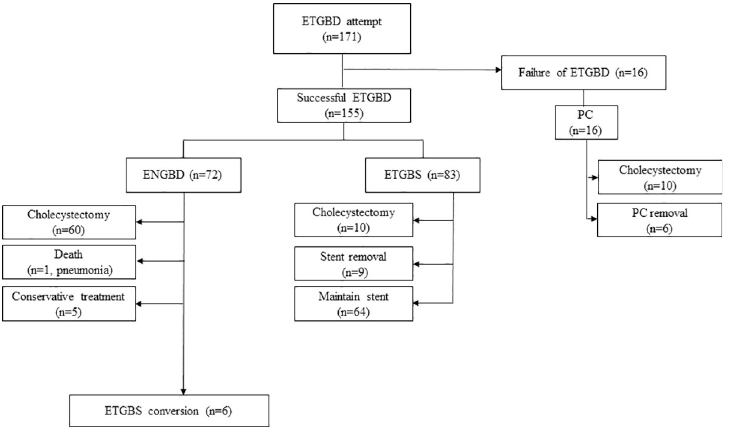
Fig 2. Flow chart of the enrolled